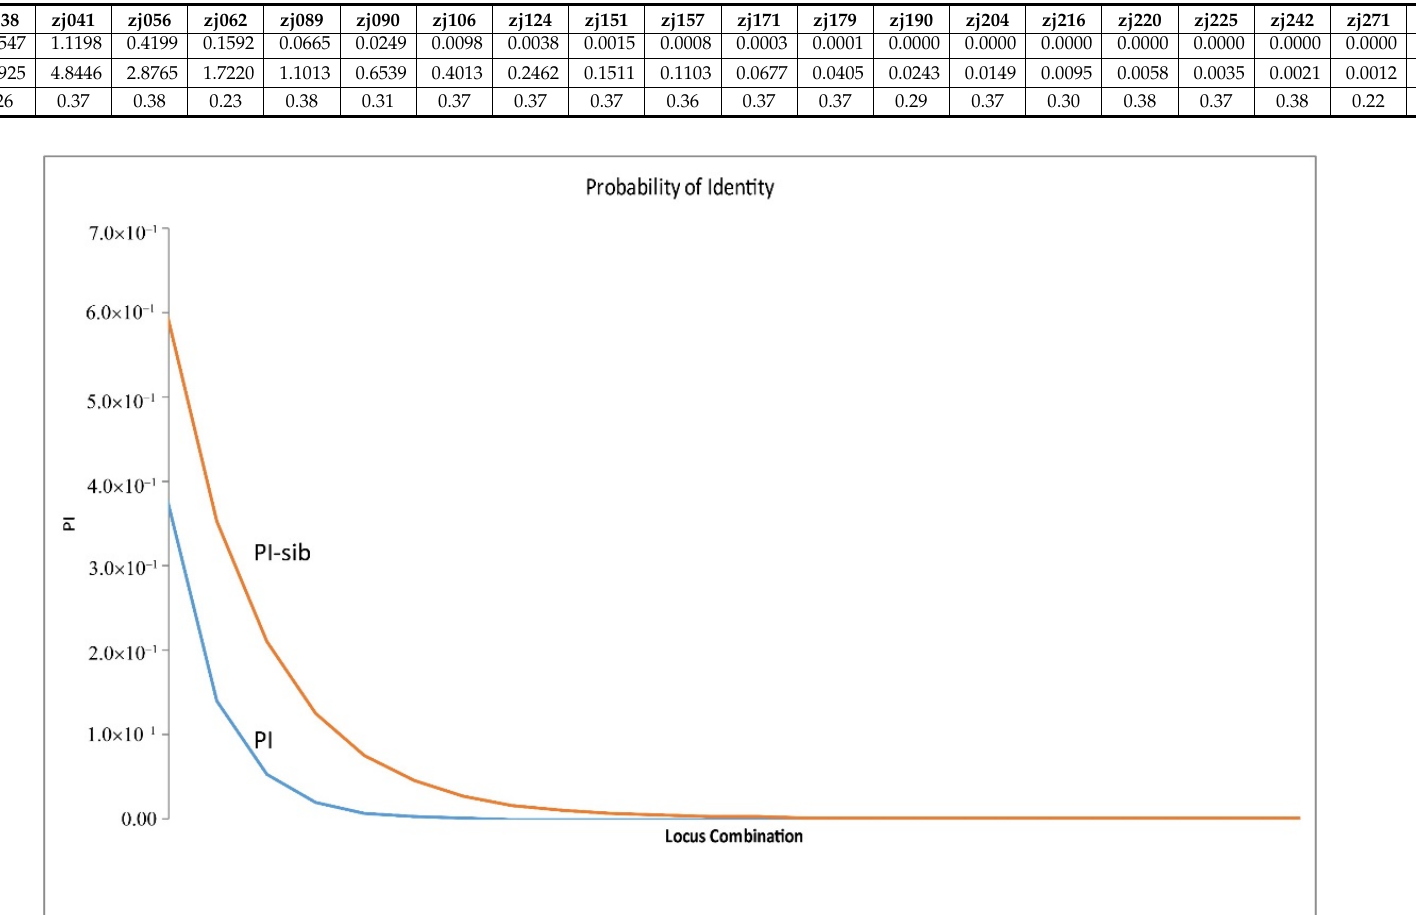
Figure 4. Sibling probabilities of identity (PID-sib) based on 24 selected SNP markers and eight